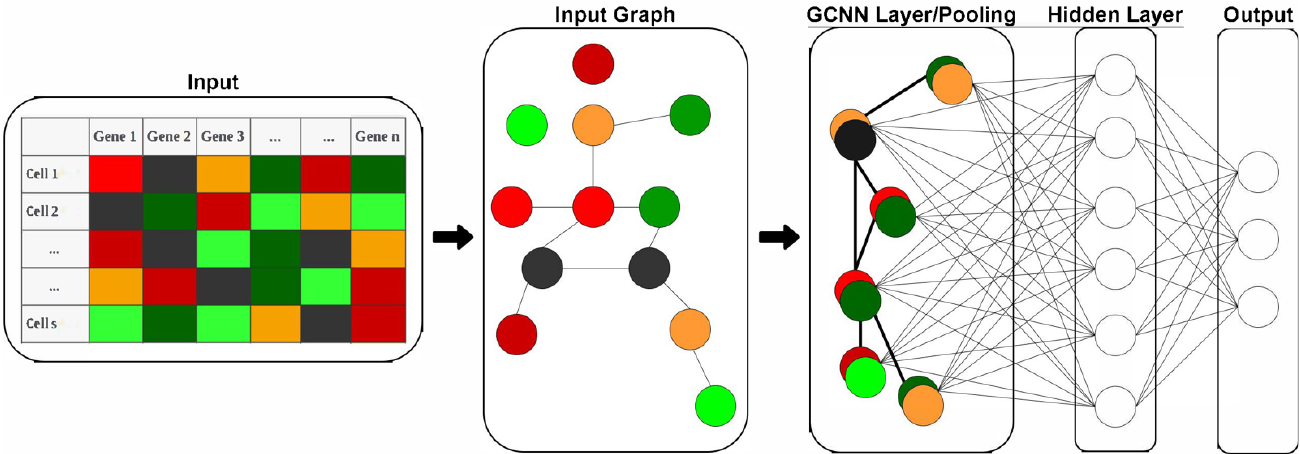
Figure 1. Structure of the developed GCNN model. The model includes a graph convolution layer and a fully connected output layer for classification. Inputs to the GCNN models are expression levels of 2000 genes in each cell and an input graph. The input graph includes 2000 genes as nodes, and edges among nodes representing gene-to-gene interactions from the GeneMania database. The input graph is then pooled into a single GCNN layer which will be fed into the hidden and output layers.